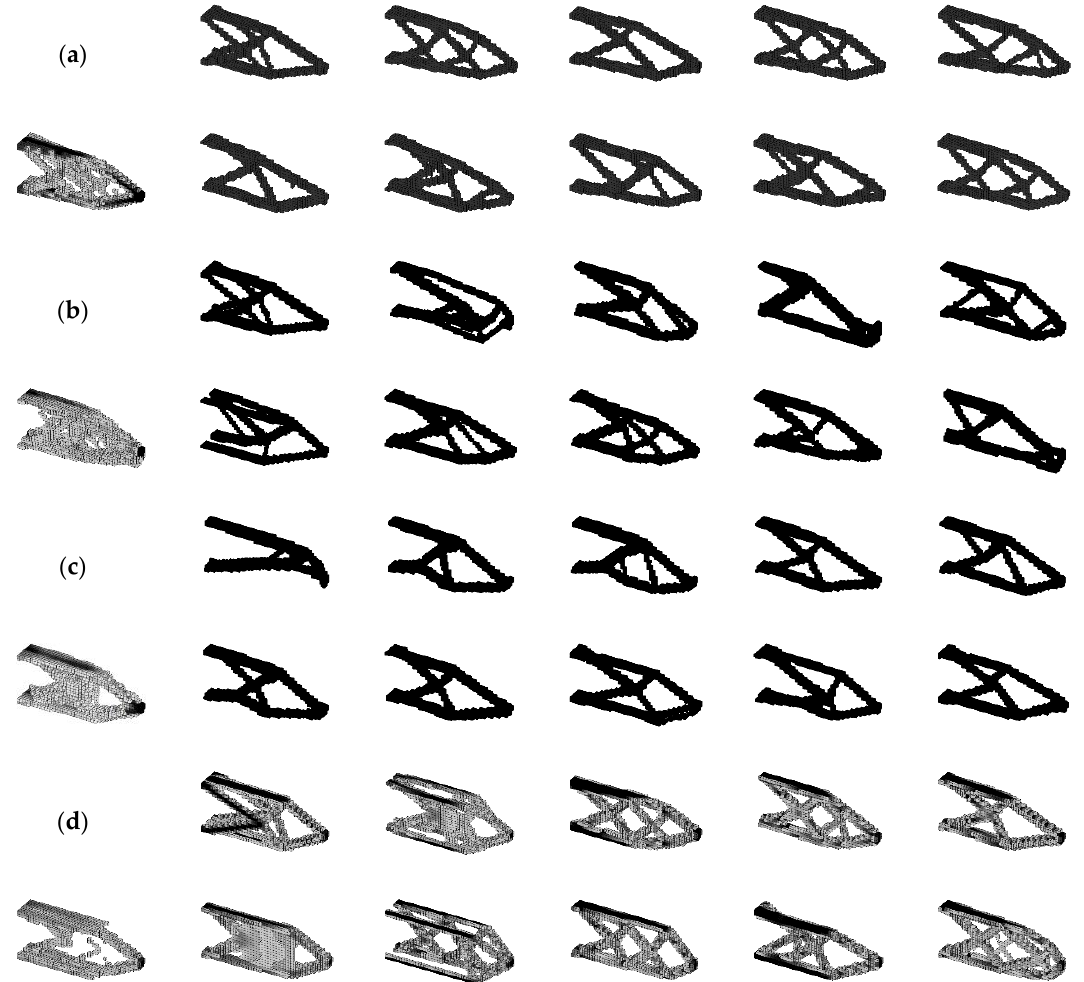
Figure 11. Generated options and stacked views of the cantilever beam by ( a ) ε -greedy policy, ( b ) UCB algorithm with BESO, ( c ) TS method with beta distribution and ( d ) UCB algorithm with SIMP.